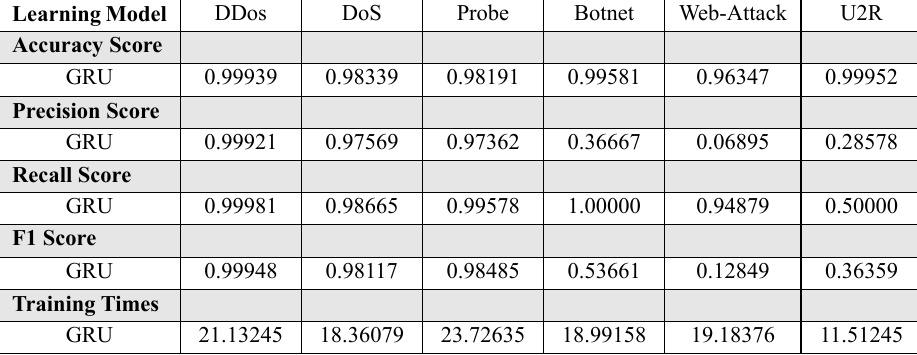
Table 2. Gru assessment with 48